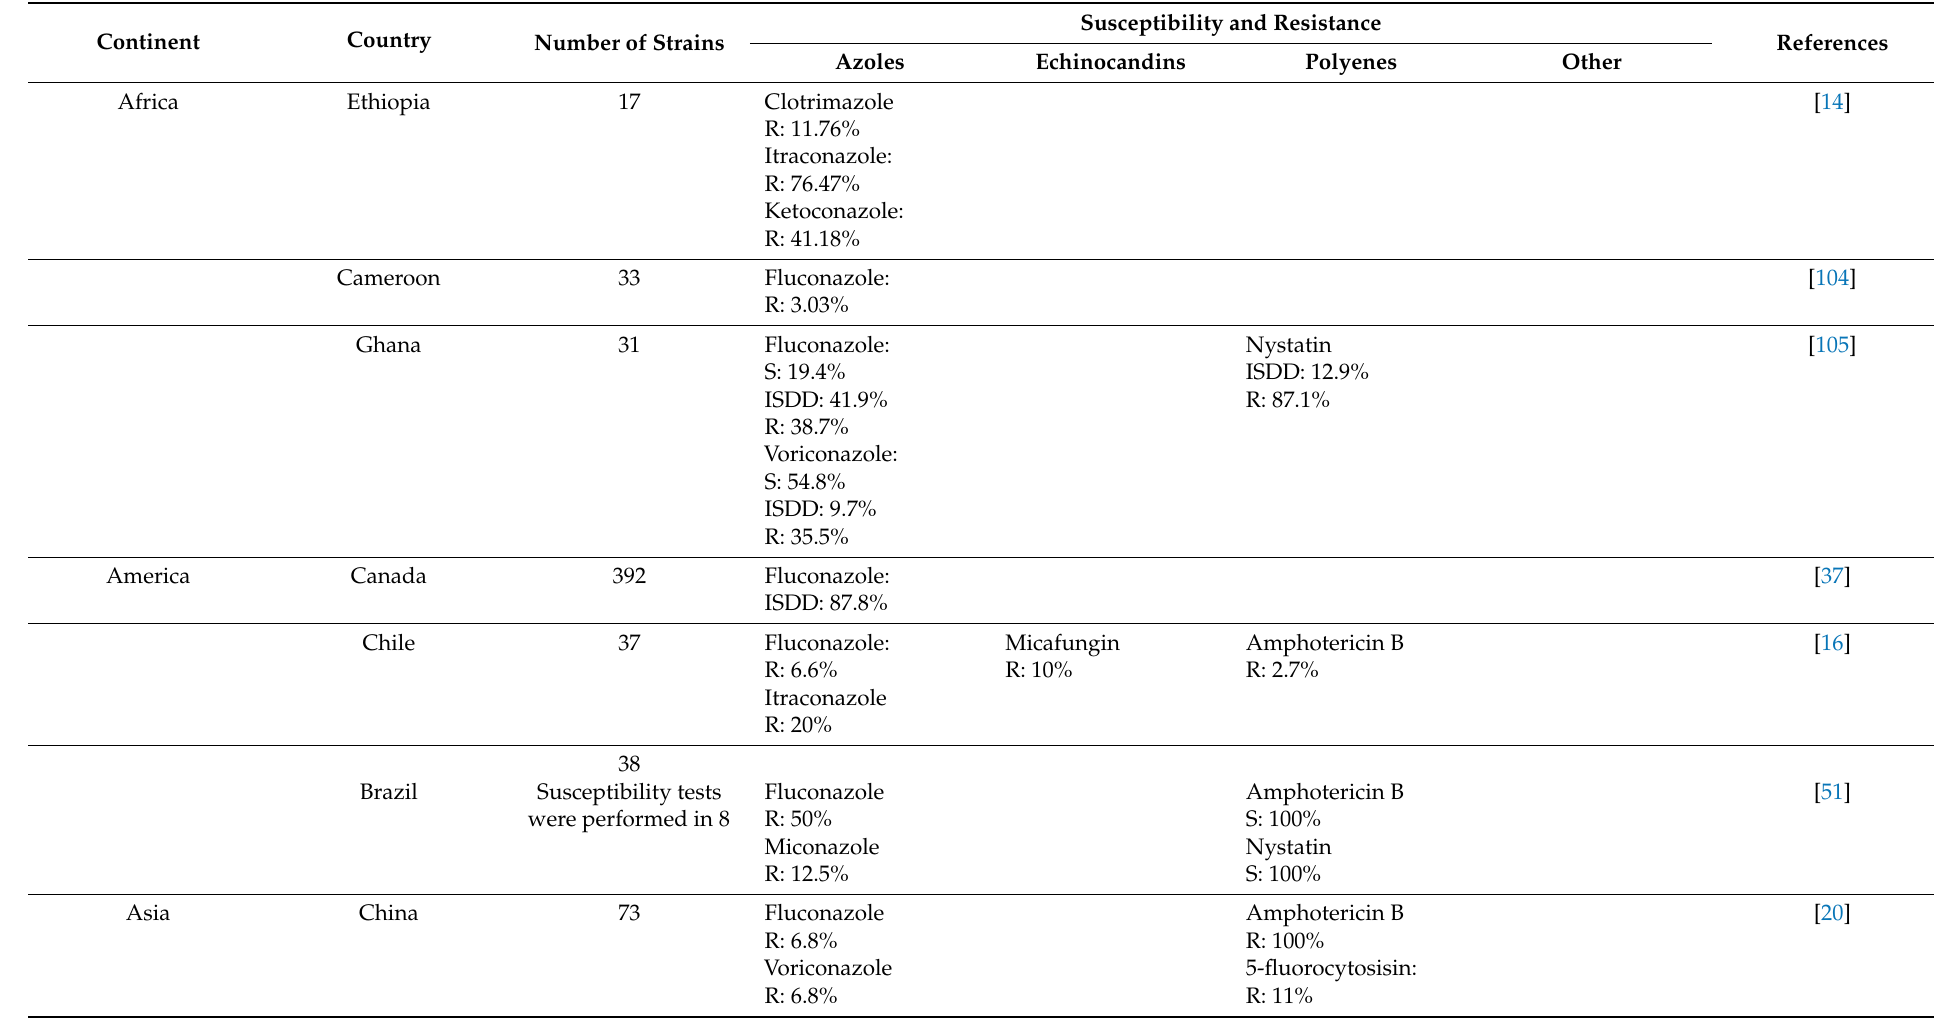
Table 1. Susceptibility variations of Candida glabrata complex per